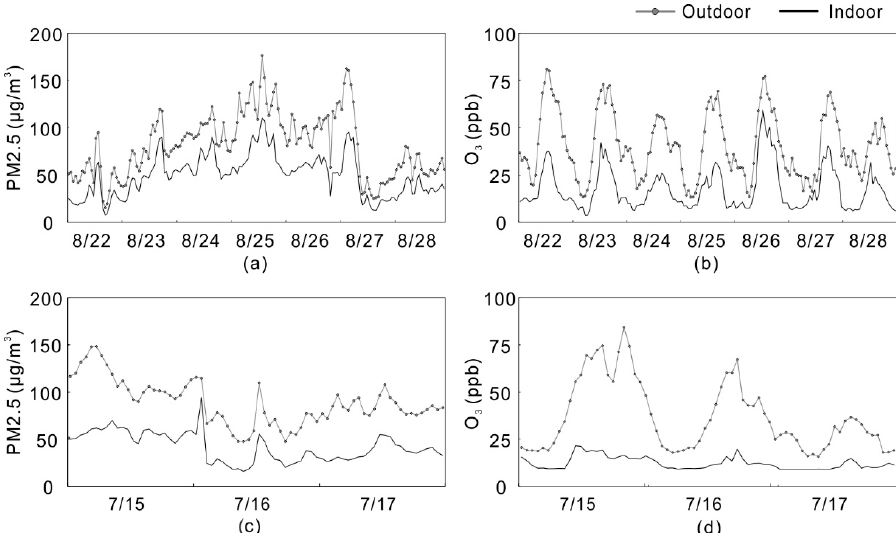
Figure 5. ( a ) Indoor and outdoor concentrations of PM2.5 during 7 days (22–28 August 2015) in